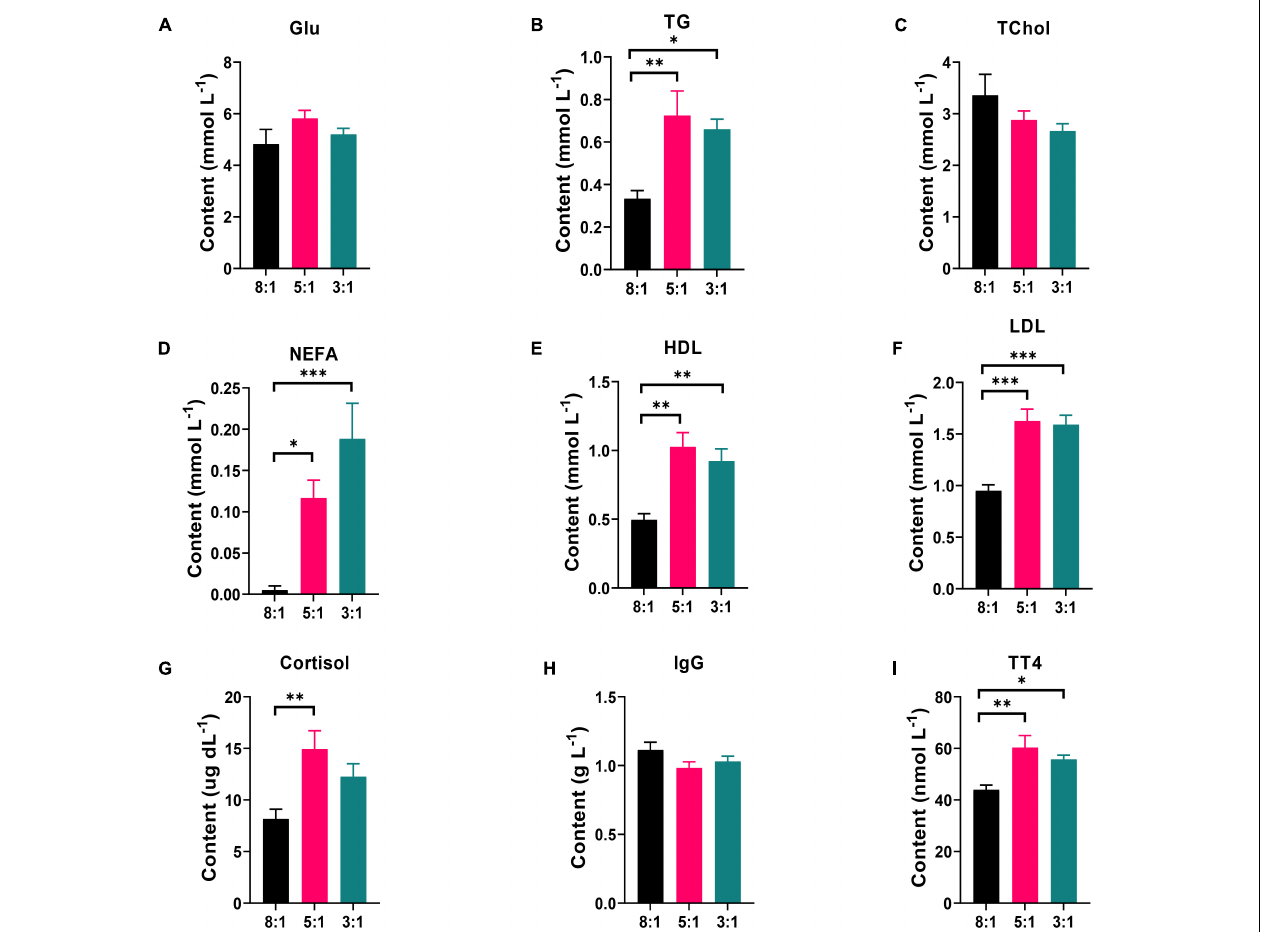
FIGURE 1 | Dietary n-6/n-3 PUFA ratio affects biochemical indexes in serum of Heigai Pigs. The contents of glucose [Glu, (A) ], triglyceride [TG, (B) ], total cholesterol [TChol, (C) ], non-esterified fatty acid [NEFA, (D) ], high-density lipoprotein [HDL, (E) ], low-density lipoprotein [LDL, (F) ], cortisol (G) , immunoglobulin G [IgG, (H) ], and total thyroxine [TT4, (I) ] in serum from Heigai pigs fed with different diets. 8:1, 5:1, 3:1: different n-6/n-3 PUFA ratio diets. Data are presented as mean ± SEM ( n = 6). * P < 0.05, ** P < 0.01, *** P < 0.001.